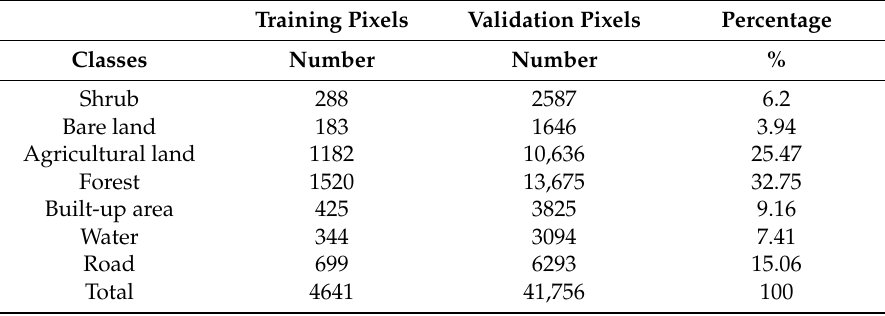
Table 4. Number of training and validation pixels.